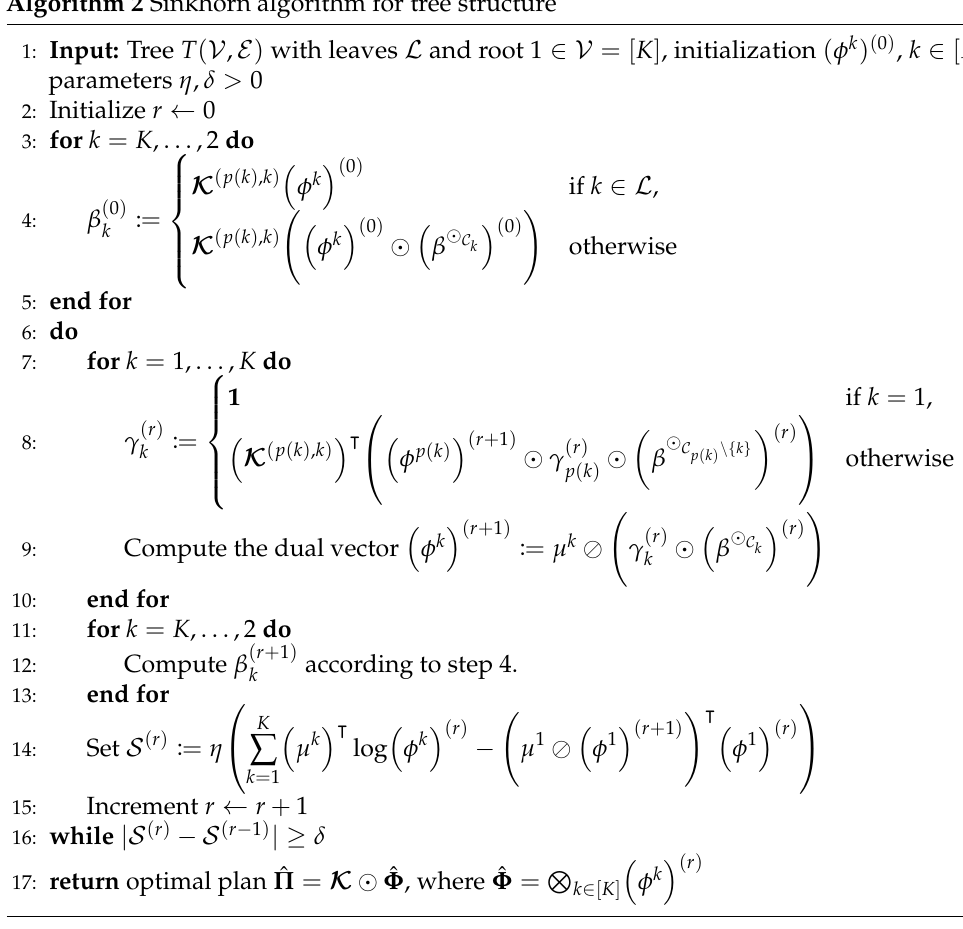
Algorithm 2 Sinkhorn algorithm for tree